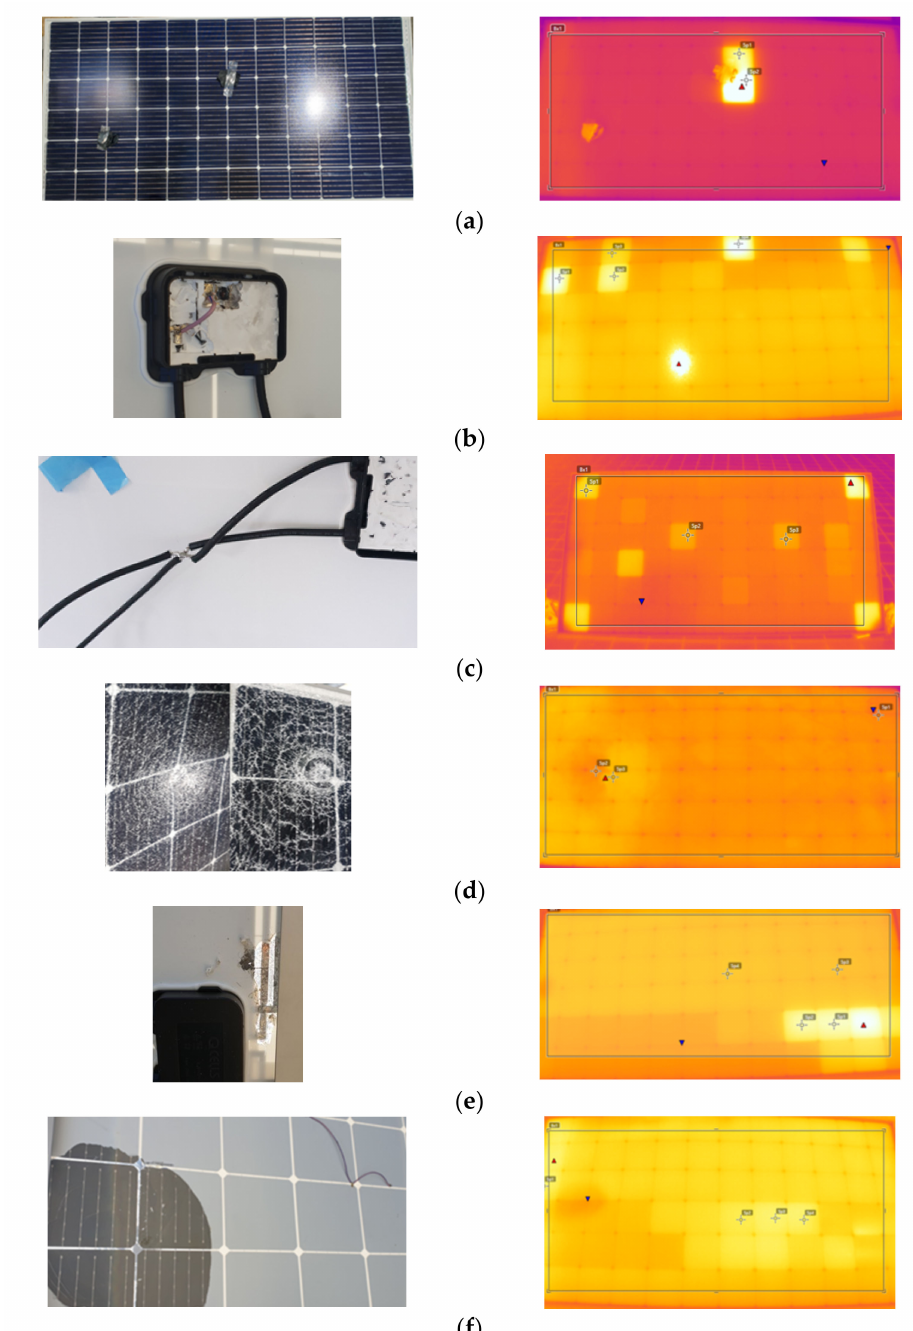
Figure 5. Photographs (left) and thermal images (right) of the 365 W panel with different failure types: ( a ) hotspot, ( b ) diode failure, ( c ) connector breakage, ( d ) panel breakage, ( e ) busbar, and ( f ) overheating of panel